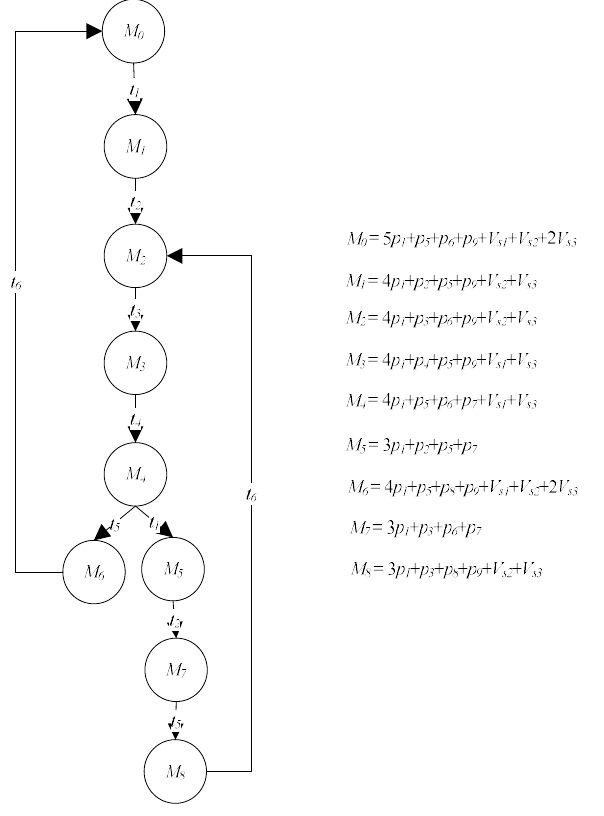
Figure 13. Reachable markings of a controlled reconfigurable S 3 PR net, as illustrated in Figure 7.